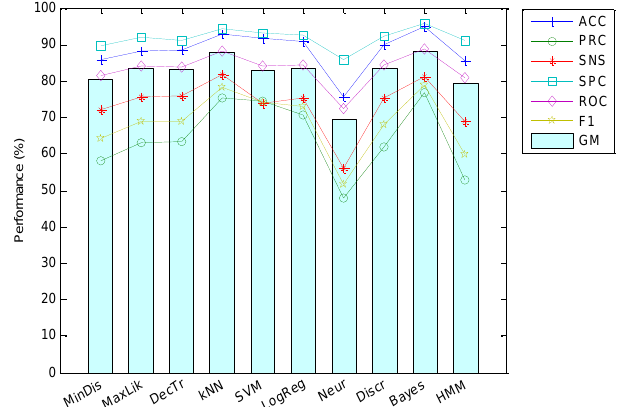
Figure 20. Classification performance using MFCCs (default options in the HTK implementation).